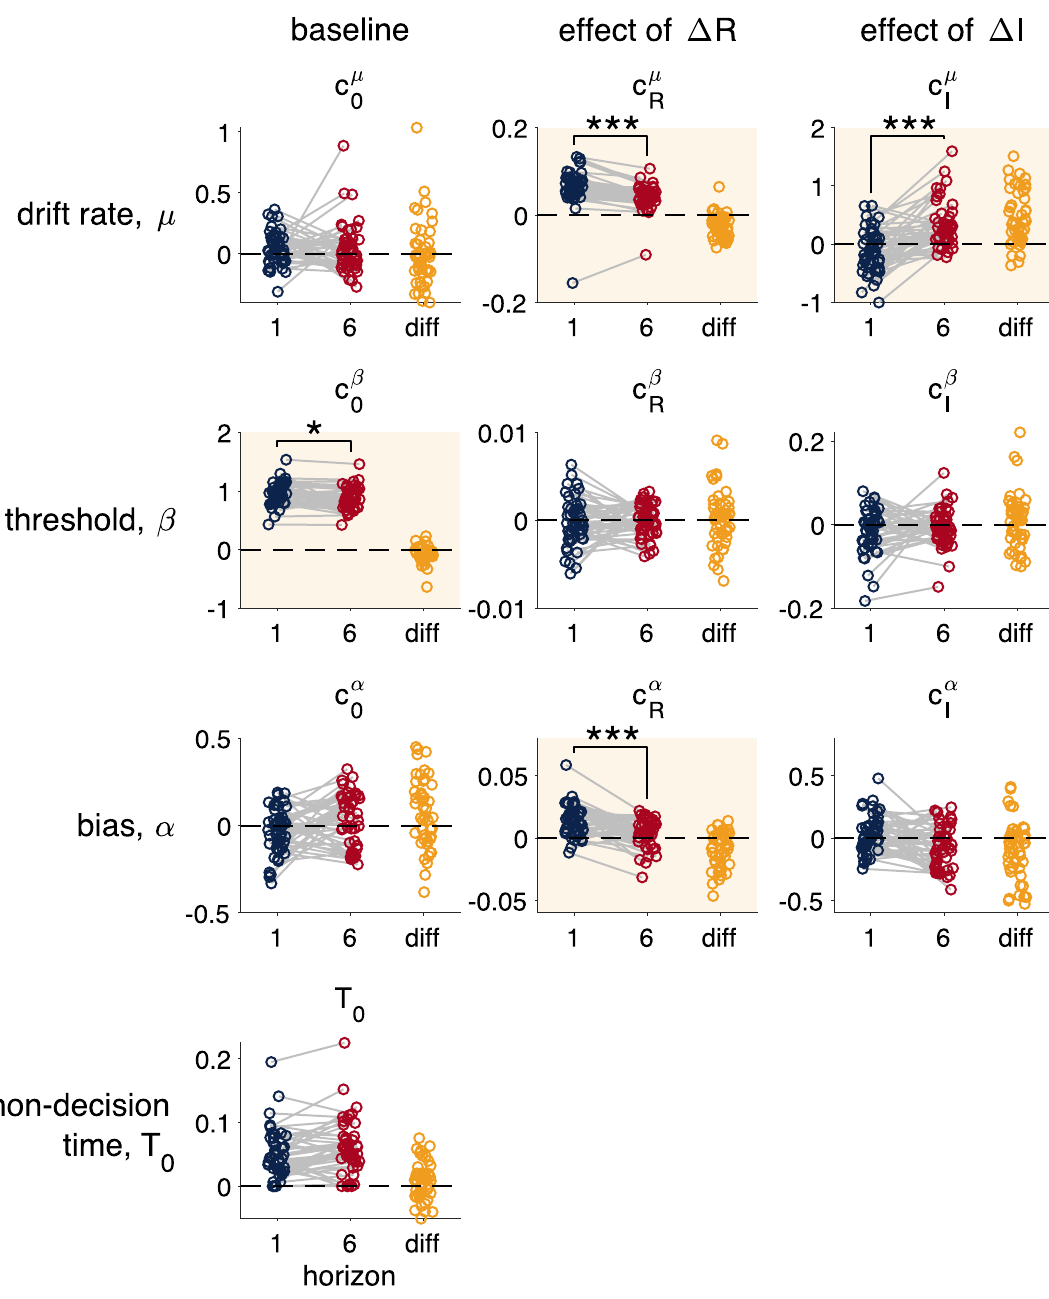
Figure 6. Fit drift-diffusion model parameters in the Horizon Task. Each row corresponds to a different parameter in the drift-diffusion model (drift rate, threshold, bias and non-decision time). Each column corresponds to a different component of each parameter (its baseline value, how it changes with reward, and how it changes with information). Parameters that change significantly between horizon 1 and horizon 6 are highlighted with a yellow background. * denotes a significant horizon difference at p < 0.01 , *** at p < 0.001 . All significance checks were Bonferroni corrected for 10 multiple